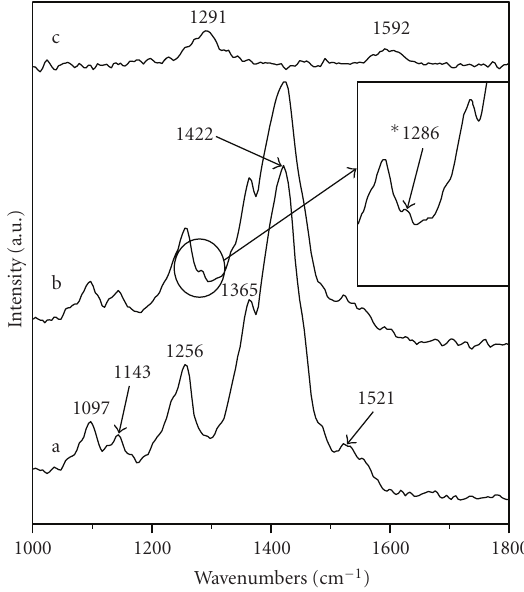
Figure 3: Raman spectra of (a) pure PEDOT:PSS, (b) M- PEDOT:PSS (0.1wt%), and (c) MWCNTs films. ∗ The inset curve shows clearly the peak of 1286 cm − 1 .